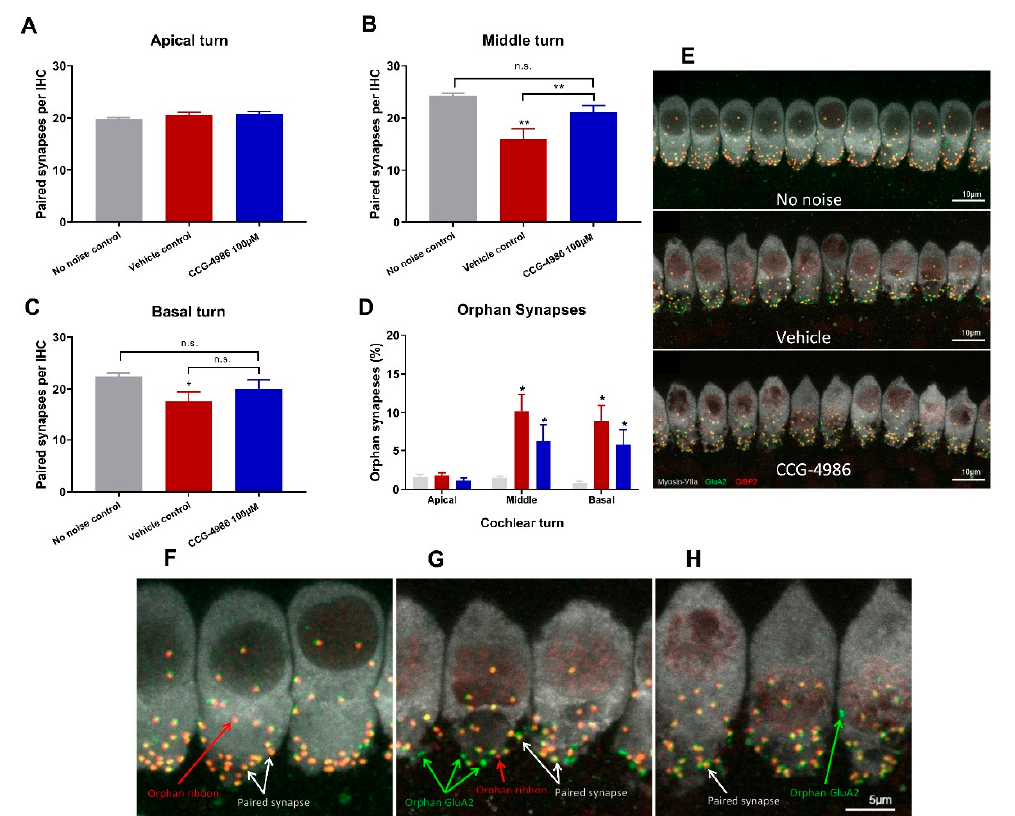
Figure 5. The average number of synapses per IHC at various frequency regions of the cochlea. ( A ) Number of paired synapses in the apical turn (low frequency region), ( B ) Middle turn (mid frequency region) and ( C ) Basal turn (high frequency region). ( D ) Number of orphaned synapses in all turns expressed as a percentage of total synapses per IHC. Data presented as mean ± SEM. No-noise control, n = 10, vehicle-treated, n = 16, CCG-4986 treated, n = 17. * p < 0.05, ** p < 0.01, n.s. not significant. One-way ANOVA followed by Holm–Sidak post-hoc test. ( E ) Representative images of IHC-auditory nerve synapses in the middle turn for controls exposed to traumatic or ambient noise. Labelling shows IHCs (grey), post-synaptic glutamate receptors (green) and pre-synaptic ribbons (red). ( F – H ) High power projection of IHC synapses in ( F ) No-noise controls, ( G ) Noise-exposed vehicle-treated and ( H ) Noise-exposed CCG-4986-treated animals. White arrows indicate paired ribbon synapses, green arrows orphaned post-synaptic glutamate receptors, and red arrows orphaned pre-synaptic ribbons.